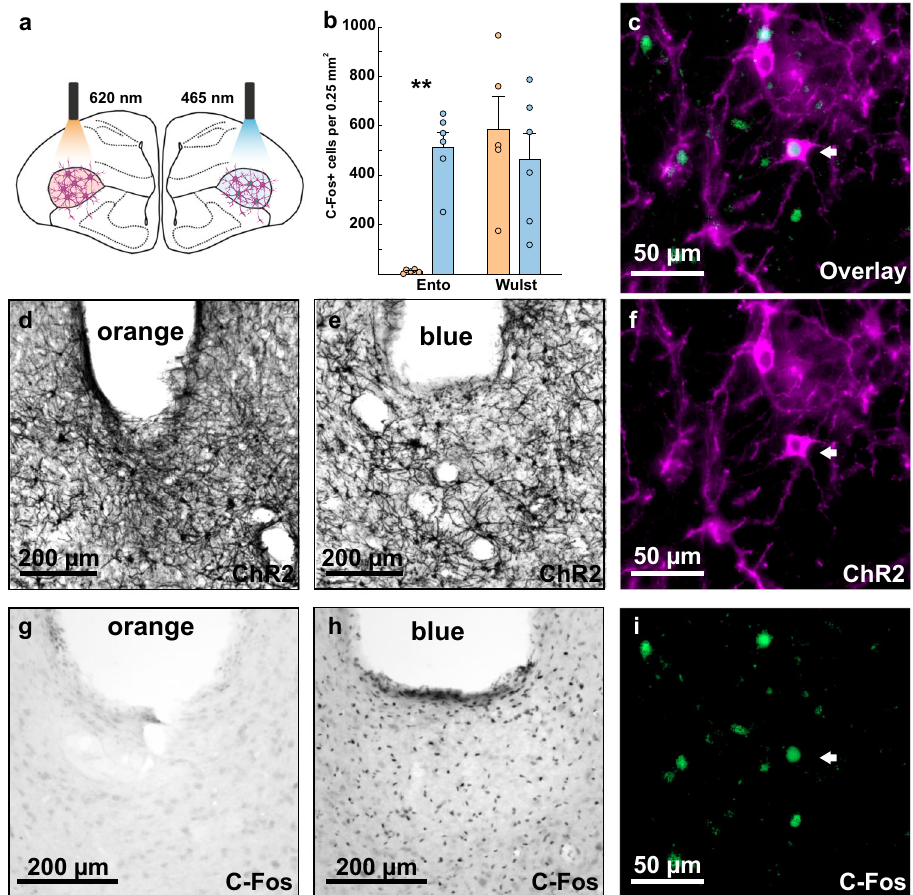
Fig. 6 Immediate early gene expression after stimulation of ChR2 expressing cells with blue light (465 nm). a Schematic drawing illustrating the experimental procedure. In three animals, two sites of one hemisphere were stimulated with orange light (620 nm), while two sites in the other hemisphere were stimulated with blue light (465 nm). b Quanti fi cation of c-Fos expression following orange and blue light stimulation in the stimulated entopallium and a non-stimulated control area in the visual wulst. Signi fi cantly more c-Fos expression was observed in the blue light stimulated hemisphere ( n = 6 sites, blue) compared to the orange stimulated hemisphere ( n = 5 sites, orange). However, in the non-stimulated visual wulst c-Fos activation was comparable. c Overlay of ChR2 expression with c-Fos expression ( fl uorescence) indicating that blue light stimulation resulted in cellular activity in ChR2 expressing cells. d ChR2 expression in the orange stimulated hemisphere. e , f ChR2 expression in the blue light stimulated hemisphere. g Little c-Fos expression occurred in the orange stimulated hemisphere. h , i Extensive c-Fos expression occurred in the blue light stimulated hemisphere. Scale bars are speci fi ed within the images. Error bars represent the standard error of the mean (SEM), dots represent the raw data. ** p <